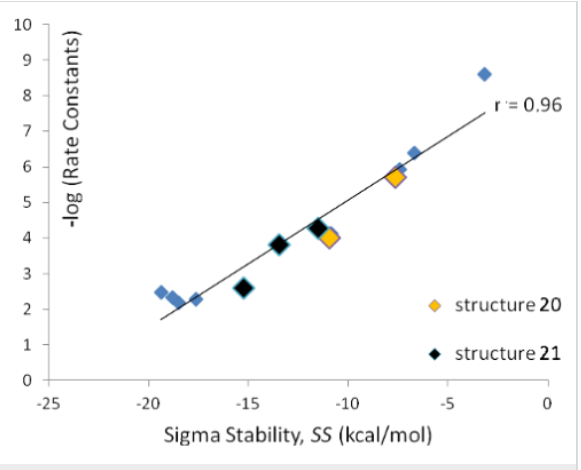
Figure 4: − log k as a function of SS in methanol for series